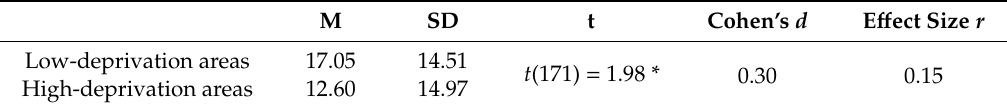
Table 4. Disparities in outdoor walking levels between low- and high-deprivation areas. M SD E ff ect Size r Low-deprivation areas